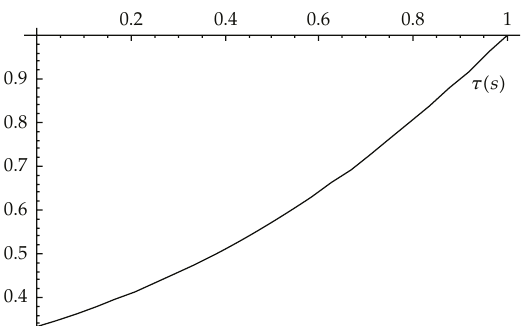
Figure 2: Graph of function τ (cid:6) s (cid:7) for α (cid:8) 5 /